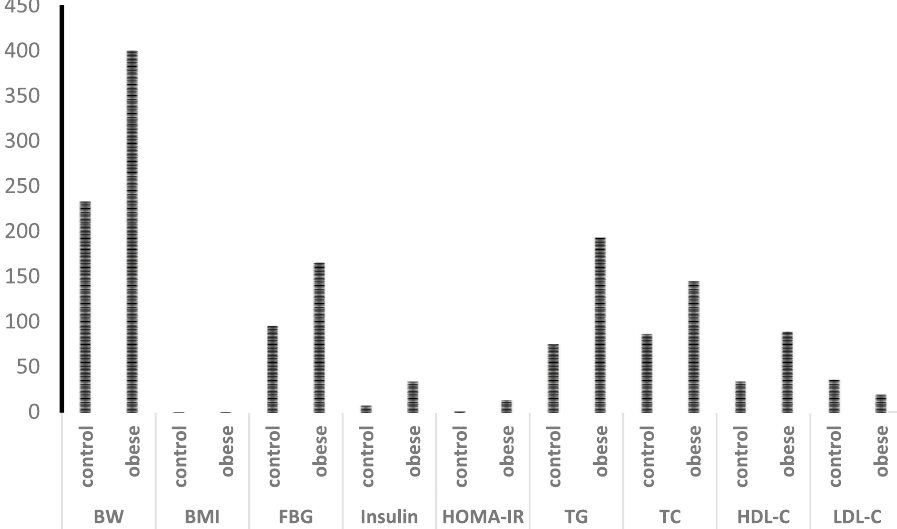
Figure 1. Data were illustrated as mean ± SD, *p < 0.05, indicating a statistically significant difference when compared with control group using independent sample t